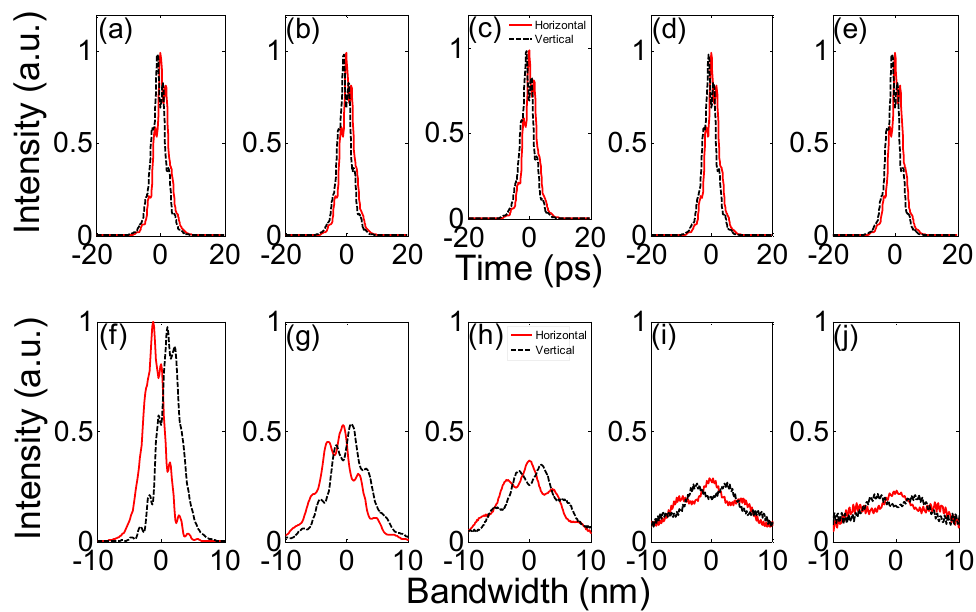
Figure 10. Theoretical results after polarization splitting when pulse chirp is changed and λ 1 = 1063 nm, λ 2 = 1065 nm.